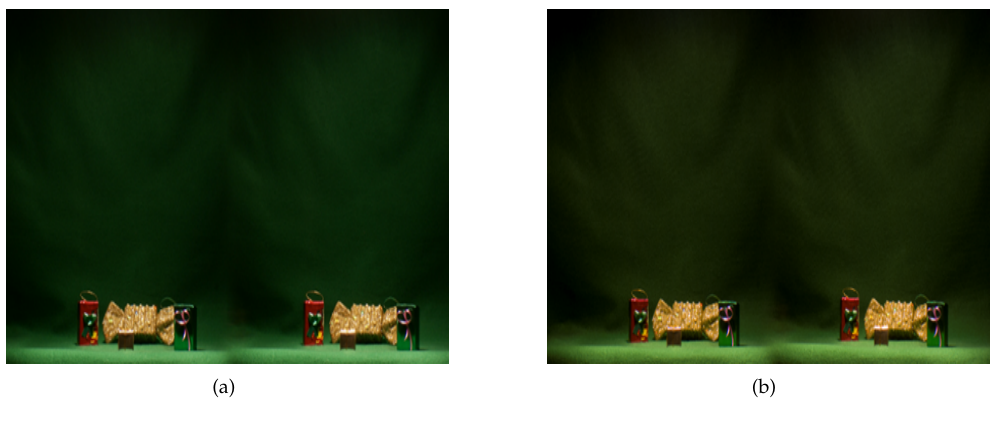
Figure 14. Adobe Photoshop CS6 Color calibration by means of Sony α 230 camera profile: ( a ) Original Stereo pair and ( b ) Recovered Stereo